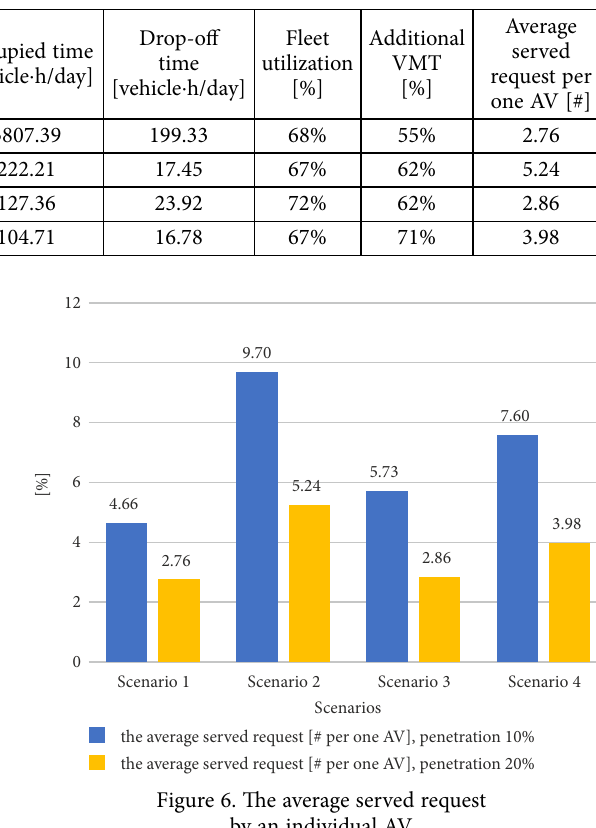
by an individual AV